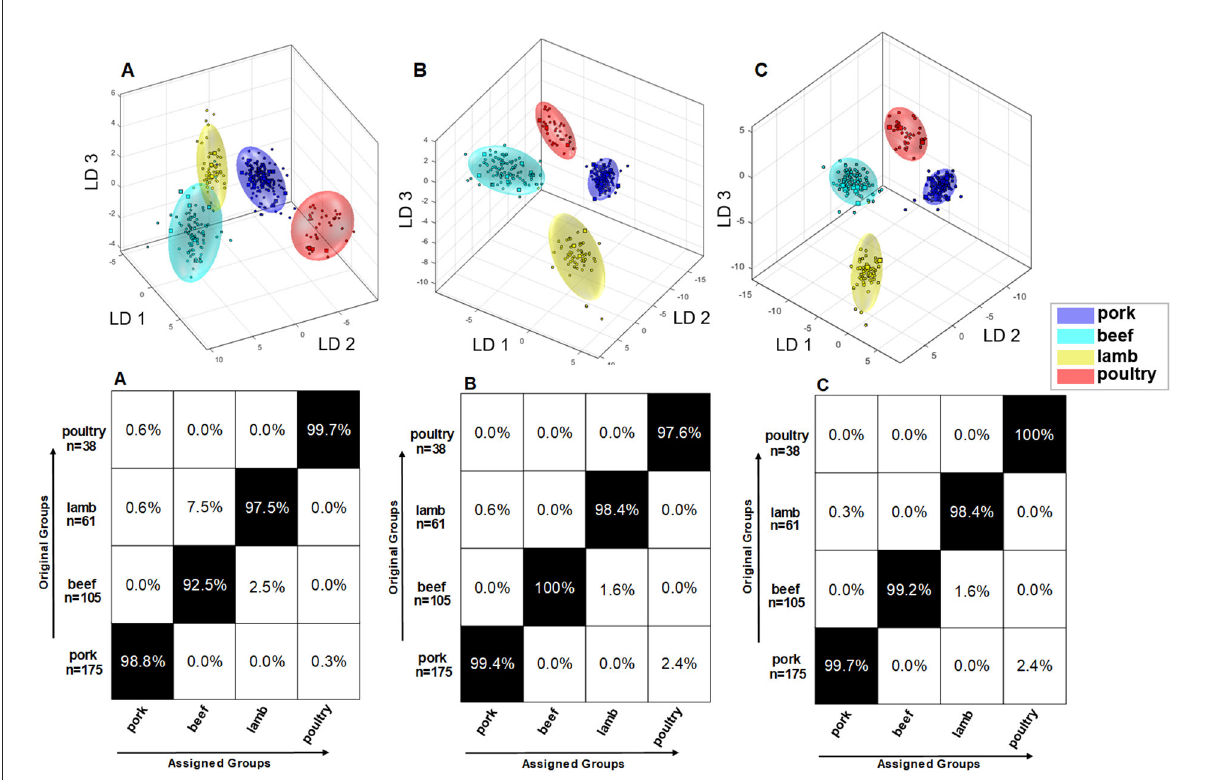
FIGURE6 (A) Results of embedded MCCV on the obtained classification model of PCA/LDA to predict the animal species via the 1 H NMR spectra of nonpolar metabolites according the method of (21). Used experiment zg30 ; 0.50–6.80 ppm; 2,000 buckets; exclusion of the residual water signal (4.84–5.10 ppm) and methanol signal (3.33–4.40 ppm); normalization: 1.50–4.050 ppm; log transformation; PCA dimensions: 16;10 CV; 10 Monte Carlo runs. (B) Results of embedded MCCV on the obtained classification model of PCA/LDA to predict the animal species i the 1